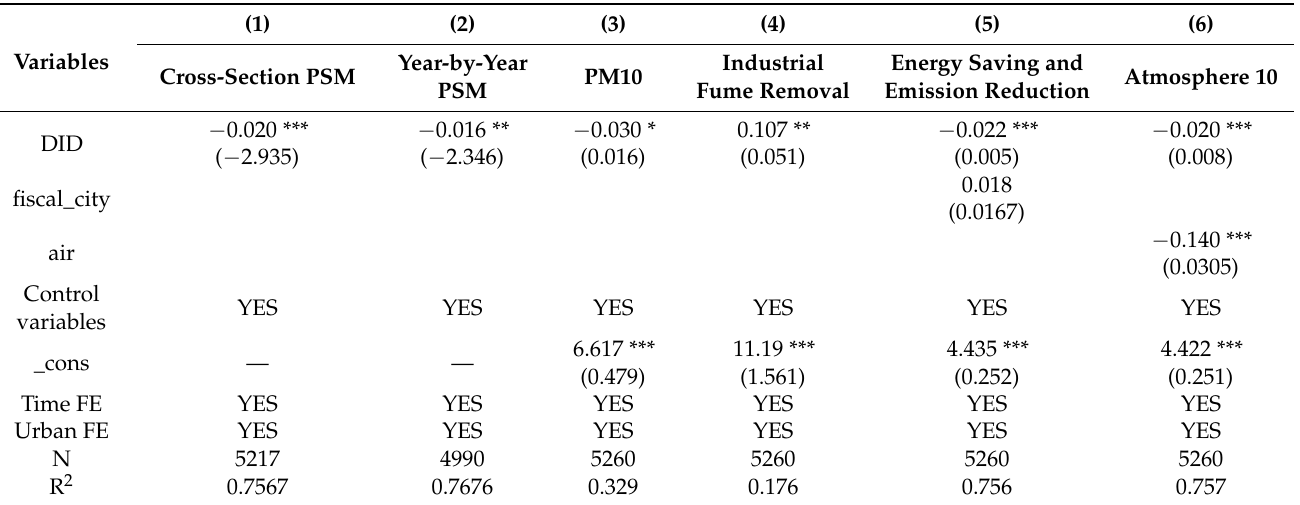
Table 3. Robustness